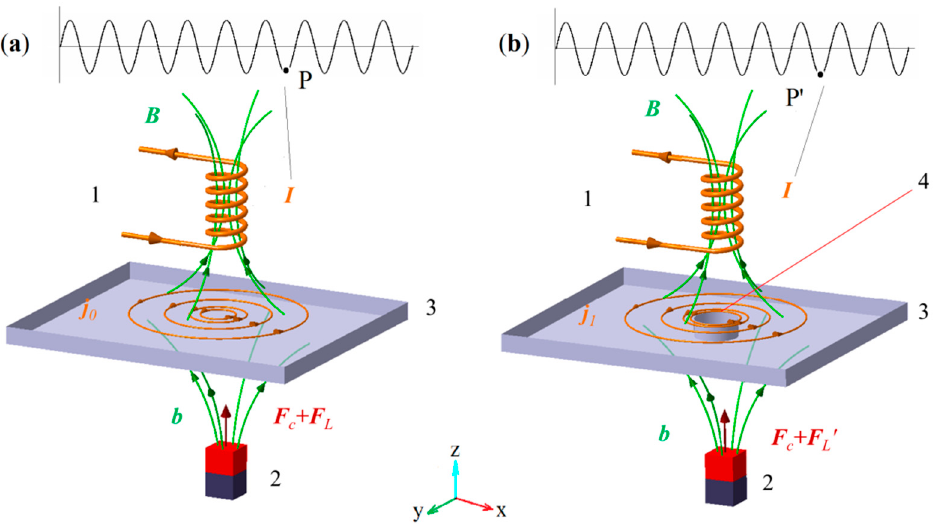
Figure 2. Principle of the vector-based eddy current testing method. F c is the magnetostatic force. ( a ) Testing sample without a defect. F L is the reaction of the Lorentz force acting on the PM without a defect; ( b ) Testing sample with a defect. F (cid:48) is the reaction of the Lorentz force acting on the PM with L a defect. 1. Exciting coil; 2. PM; 3. Copper plate; 4.